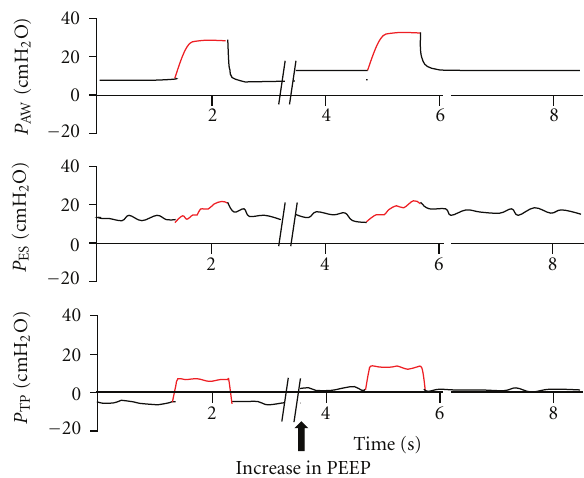
Figure 2: Negative transpulmonary pressure at end-expiration may subject the lungs to cyclic collapse. Black arrow indicates the point where PEEP was raised to a level that would ensure a slightly positive end-expiratory transpulmonary pressure. P Aw = airway opening pressure, P ES = esophageal pressure, P TP = transpulmonary pressure.